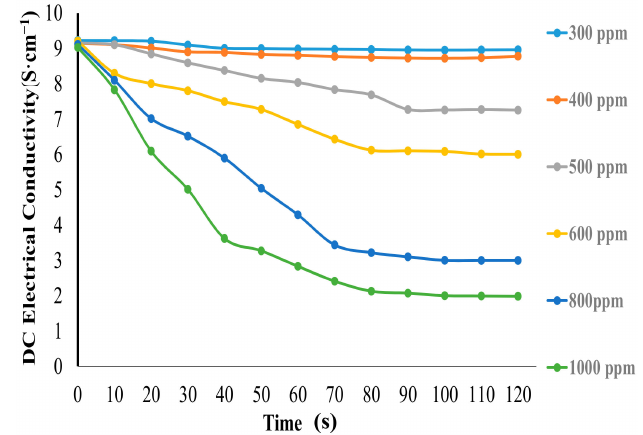
Figure 7. E ff ect on the DC electrical conductivity of the PPy / MoS 2 nanocomposites upon exposure to ammonia vapors at di ff erent concentrations.